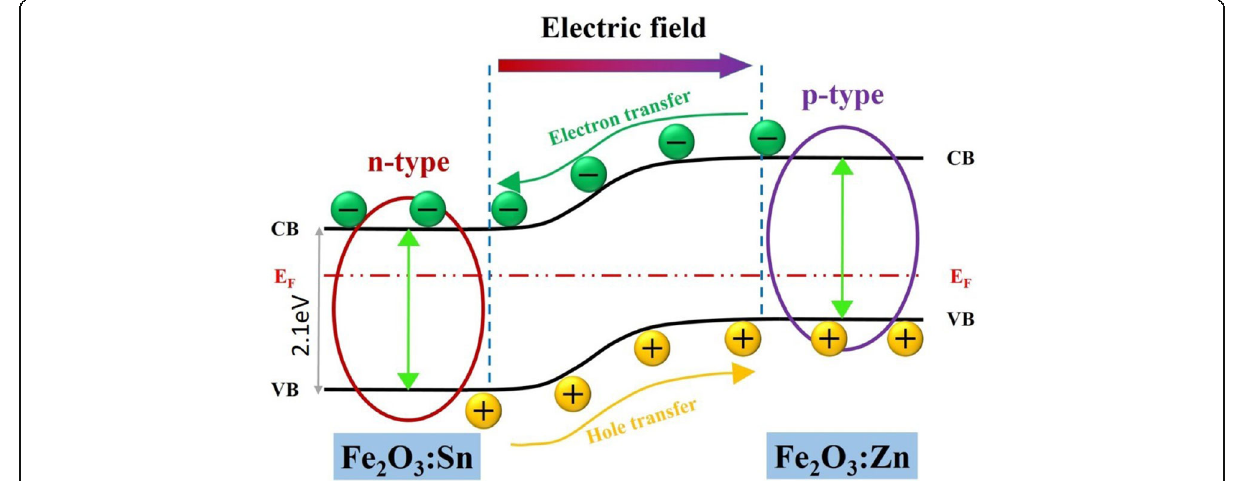
Fig. 1 Concept of the p-n junction in a photoelectrode of polyhedral pseudocubic α -Fe 2 O